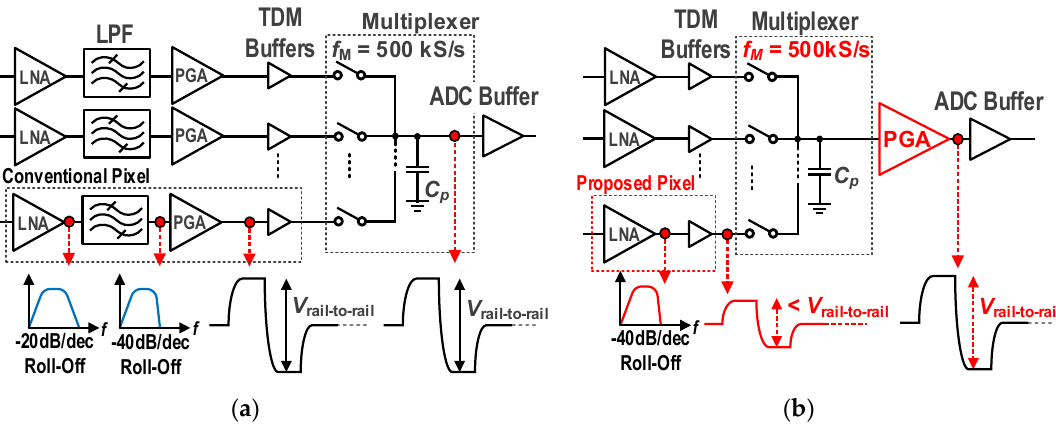
Figure 7. Pixel structure in a neural recording time-division multiplexing (TDM) system: ( a ) conventional and ( b ) proposed pixel structures. Table 1. Summary and comparison with recent state-of-the-art